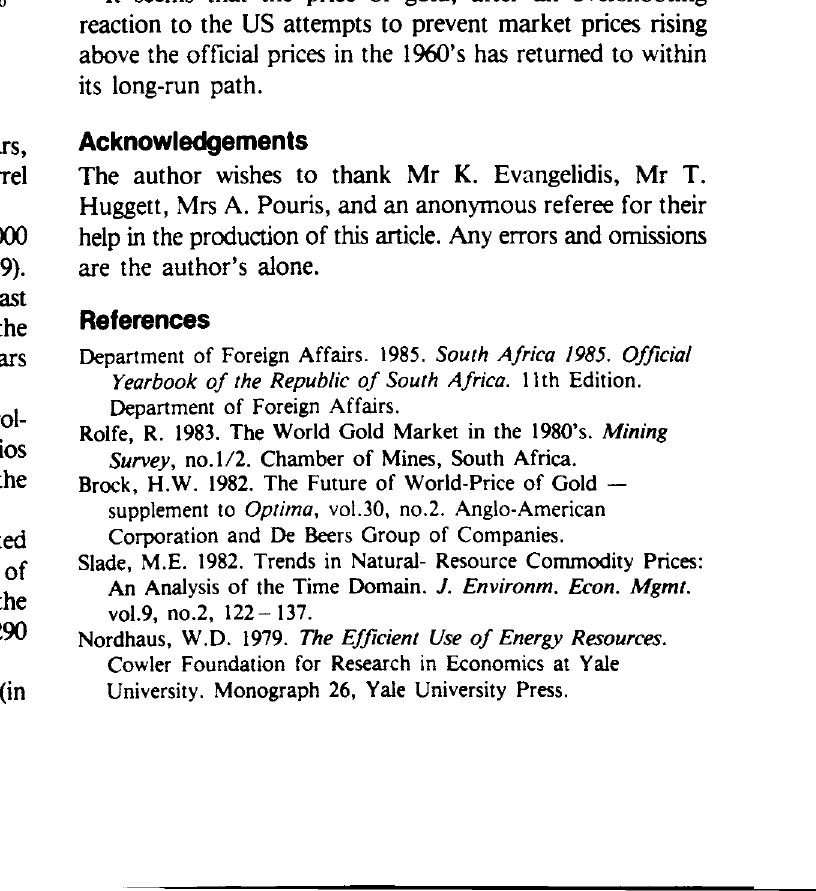
Figure 4 Deflated prices of petroleum and trend